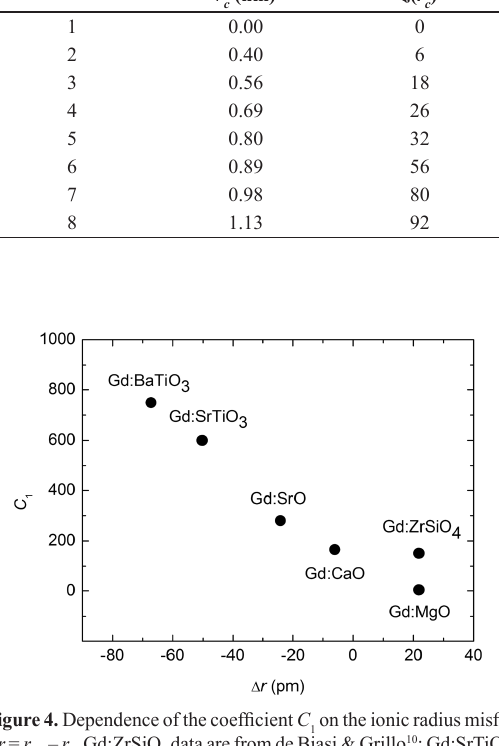
Figure 3 . The experimental results fit the theoretical curve for n = 7, which corresponds, according to Table 3, to a range r = 0.98 nm for the exchange C